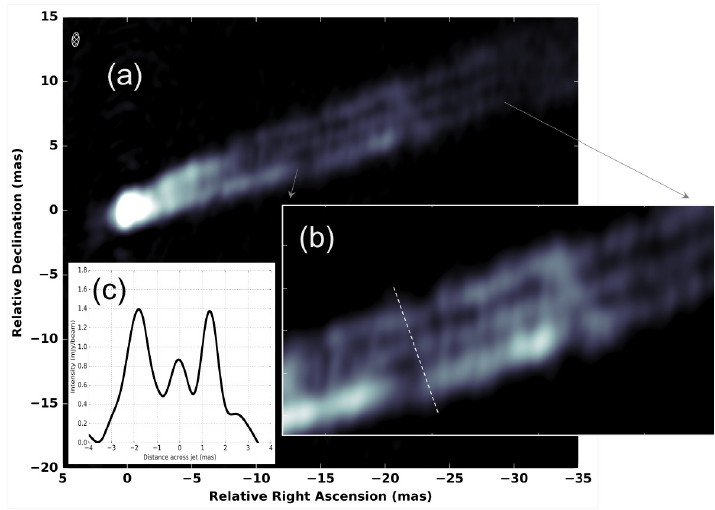
Figure 2. ( a ) VLBA+Y27 15 GHz image of the M87 jet observed in December 2015. This image is produced with a natural weighting scheme. The beam size is 1.14 × 0.55mas (shown in the upper left corner); ( b ) Zoom-up view of the parsec-scale region of the jet; ( c ) Slice of the total intensity at a distance of 15mas from the core (shown by the dashed line in the panel ( b